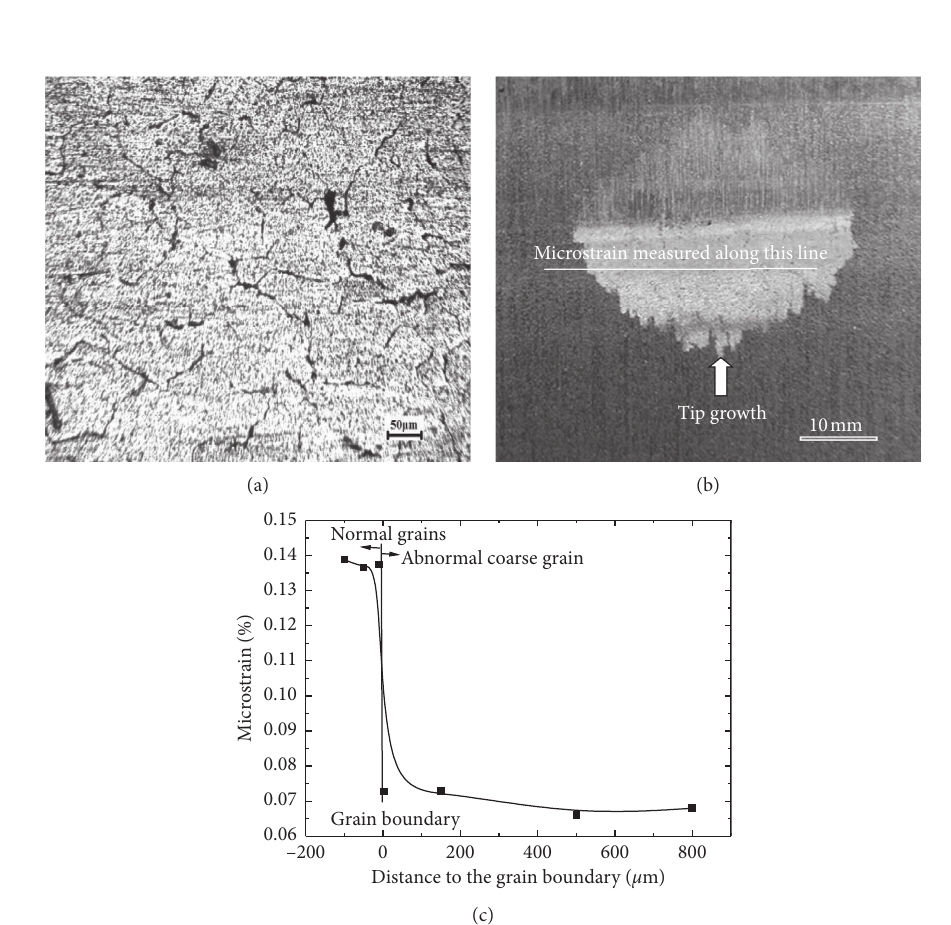
Figure 1: Macrographs of the abnormal grains in annealed twin-roller cast 1235 aluminium alloys. (a) The optical microstructure of the twin-roller cast alloy. (b) Morphology of the abnormal grain formed in the following annealing process. (c) Microstrain across the abnormal